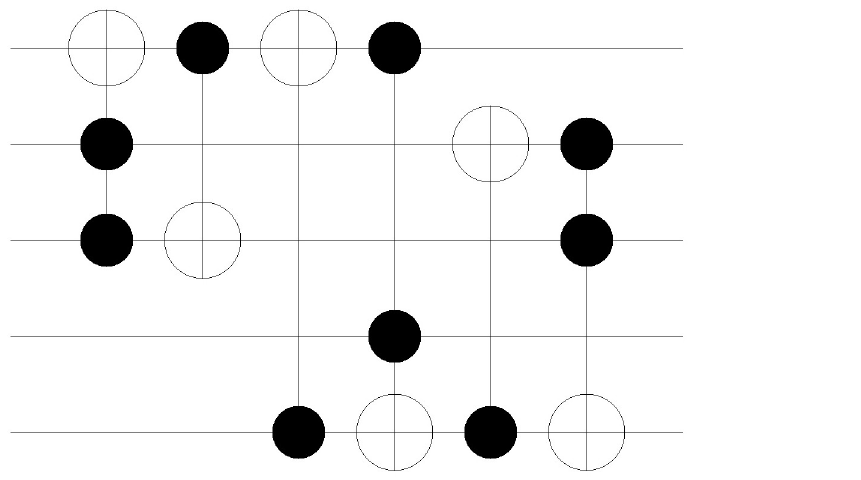
Fig 16. Resulting circuits of No. 18 4gt4_v1 with varying N